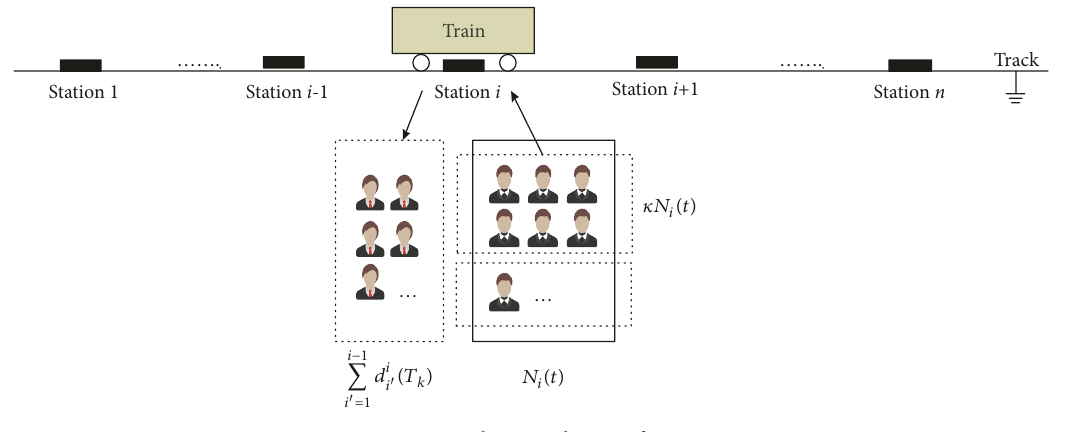
Figure 2: Schematic diagram for 𝐴 𝑖